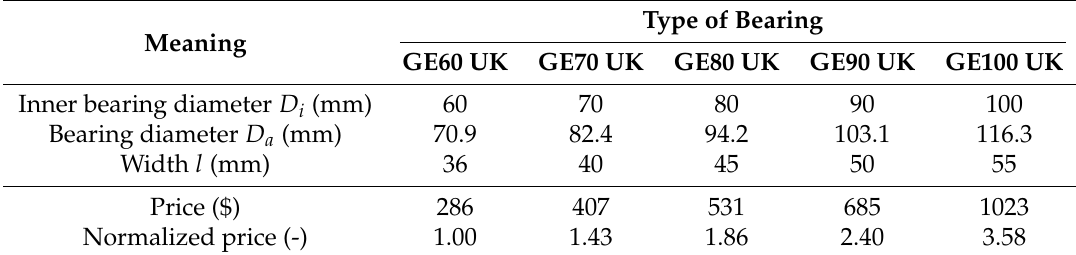
Table 3. Considered plain bearing types (GE-type bearings from Schaeffler). The dimension values are taken according to [24], and the prices are taken from [25]. The exact meaning of the diameter values D i and D a can be seen in Figure